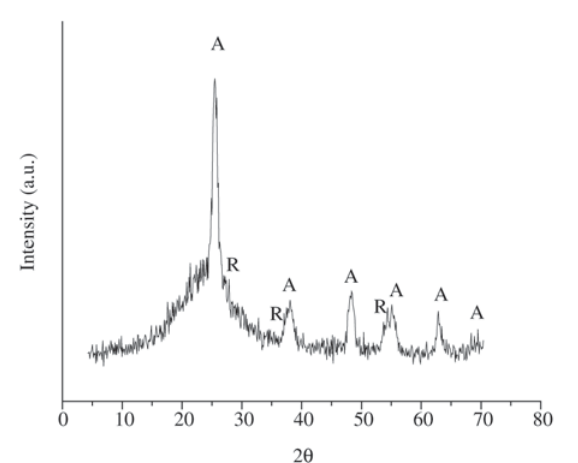
Figure 8. X-ray diffraction peaks to STD